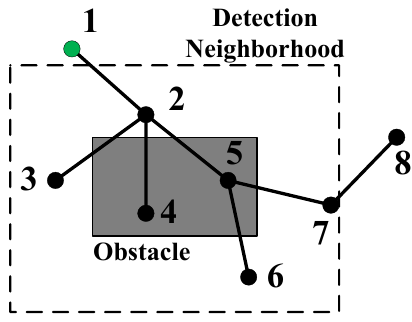
Figure 4. The main idea of pruning algorithm. 8 nodes of a tree are shown as the solid circles in this figure, numbered from 1 to 8. The green solid circle represents the root